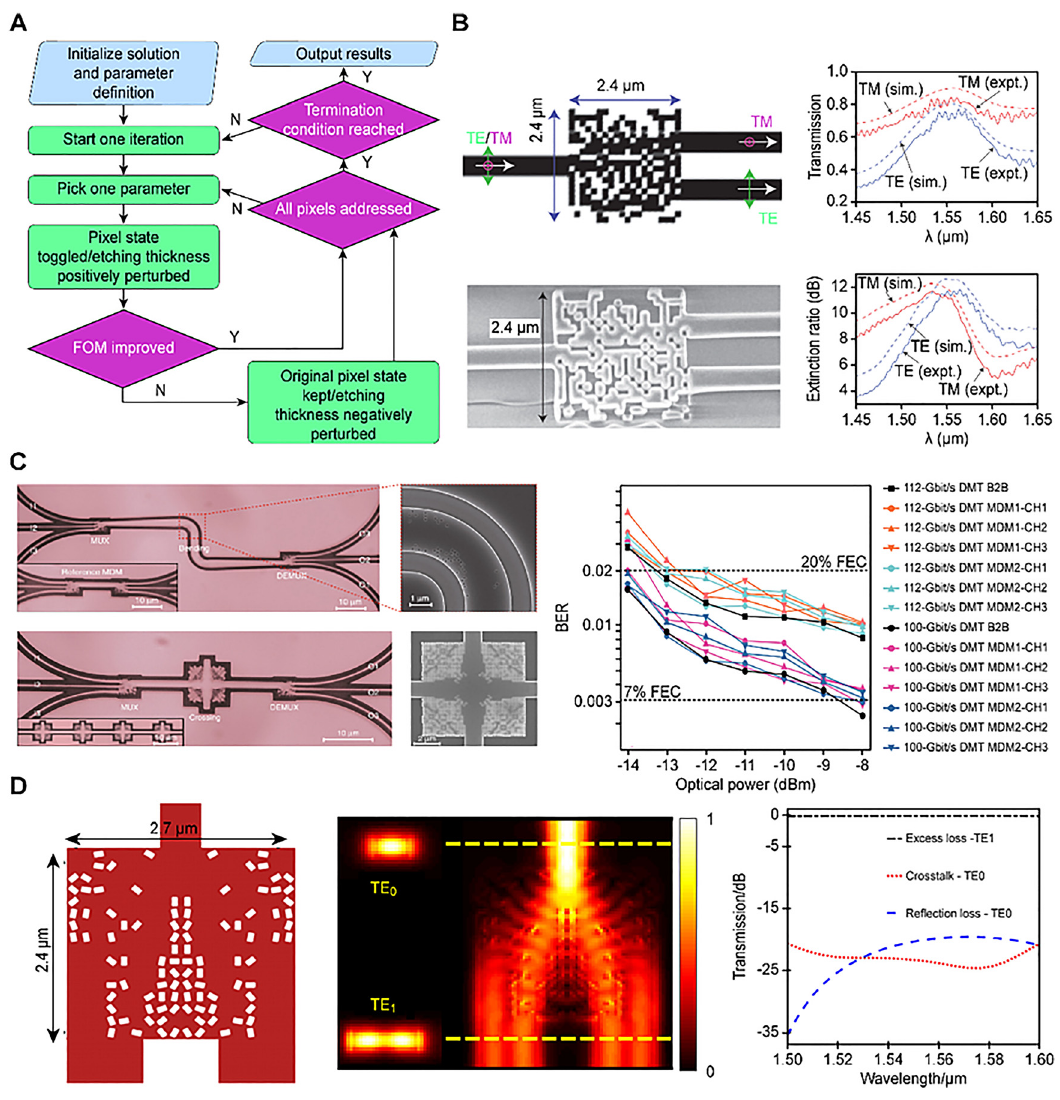
Figure 3: Illustration of the DBS algorithm. (A) Flow chart of the DBS algorithm. Reproduced with permission [49]. Copyright 2015, Optical Society of America. (B) Integrated- nanophotonics PBS. Upper left: geometry of the PBS. Lower left: SEM image of the fabricated PBS. Upper right: measured and simulated transmission ef fi ciencies of the PBS. Lower right: measured and simulated extinction ratios of the PBS. Reproduced with permission [50]. Copyright2015,NaturePublishingGroup.(C)Mode-divisionmultiplexedphotoniccircuitsthatcanbearbitrarilyrouted.Upperleft:SEMimage ofthemode-divisionmultiplexing(MDM)circuitconsistingofamultiplexer(MUX),bendinganddemultiplexer(DEMUX).Lowerleft:SEMimage oftheMDMcircuitconsistingofMUX,crossingandDEMUX.Right:measuredbiterrorratecurvesfortheback-to-backandMDMtransmissions of100and112Gbit/sdiscretemulti-tones.Reproducedwithpermission[20].Copyright2019,NaturePublishingGroup.(D)Ultra-compact1 × 2 modeconverter.Left:Geometryoftheconverter.Middle:simulatedsteady-statelightintensitydistributionatawavelengthof1550nm.Right: Simulated transmission ef fi ciency, extinction ratio and re fl ection of the converter. Reproduced with permission [35]. Copyright 2020, Optical Society of